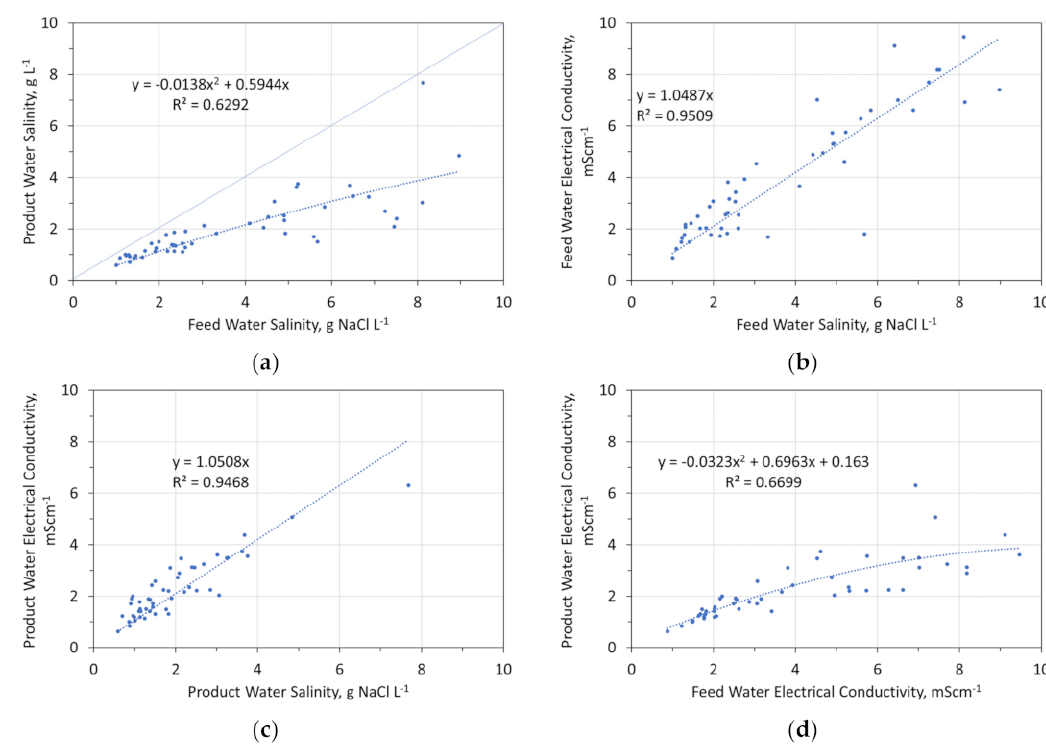
Figure A1. Feed water and product water salinity measurements. ( a ), Feed water salinity versus Product water salinity; ( b ), Feed water salinity versus Feed Water electrical conductivity; ( c ), Product water salinity versus Product water electrical conductivity; ( d ), Feed water electrical conductivity versus Product water electrical conductivity.